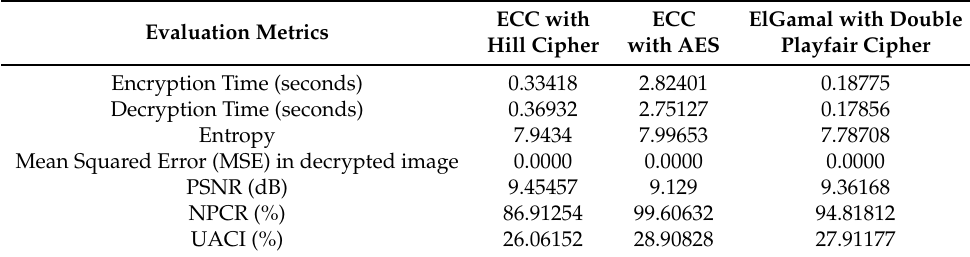
Table 2. Metric measures for Eggs